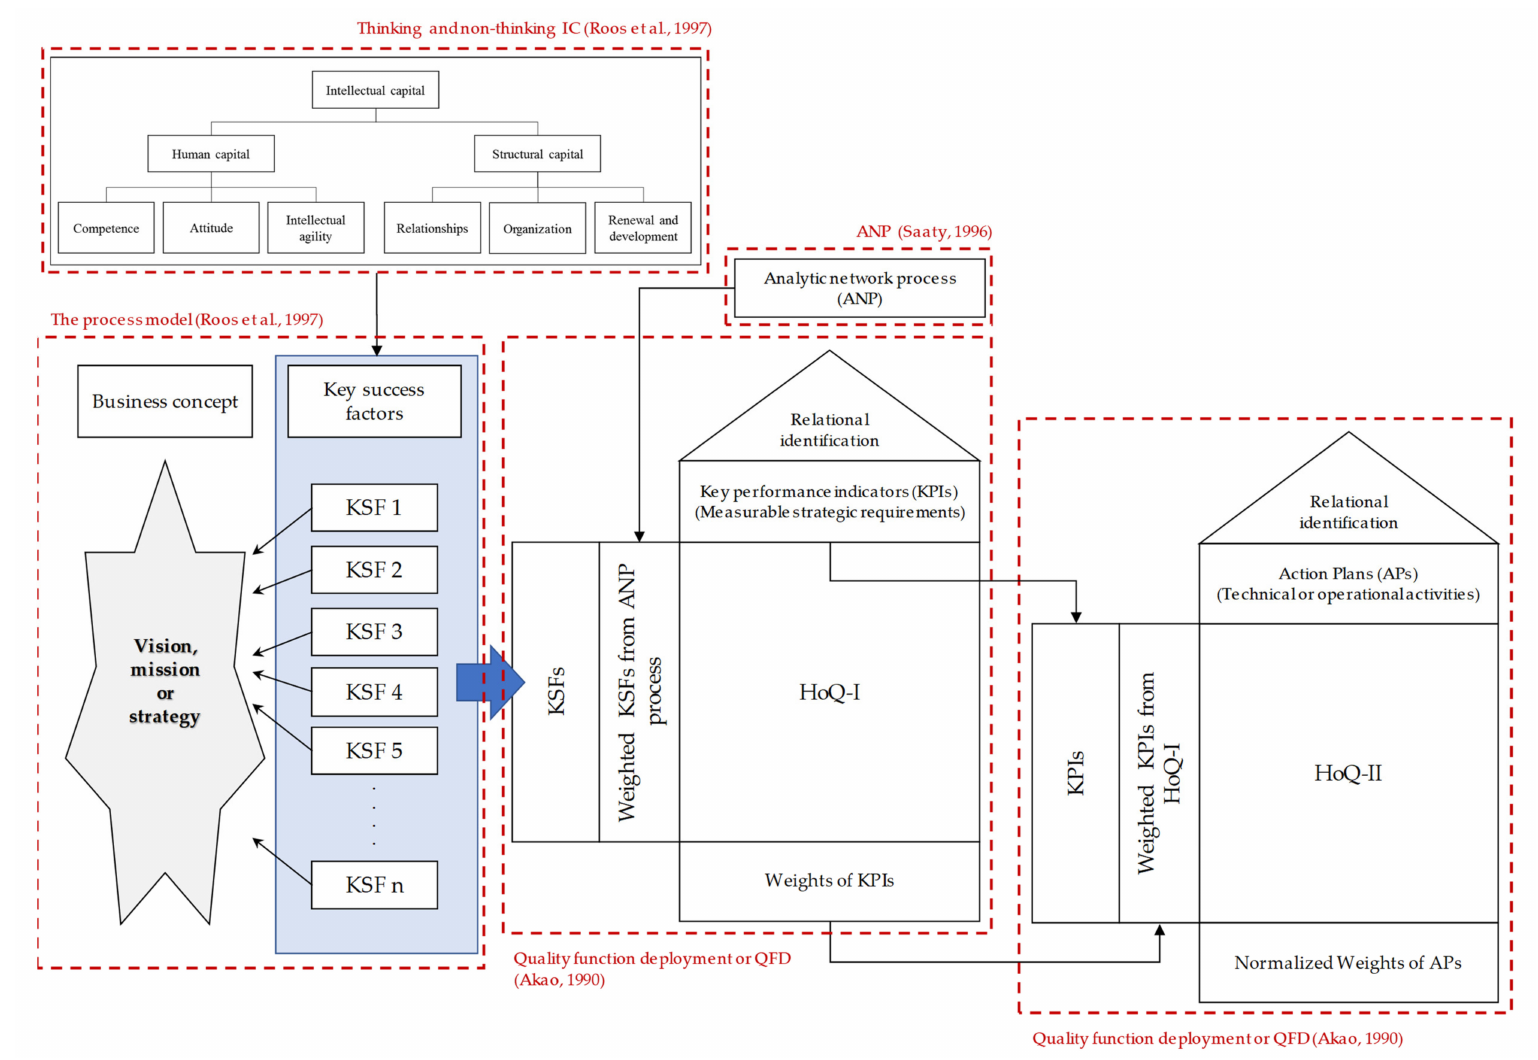
Figure 1. A research